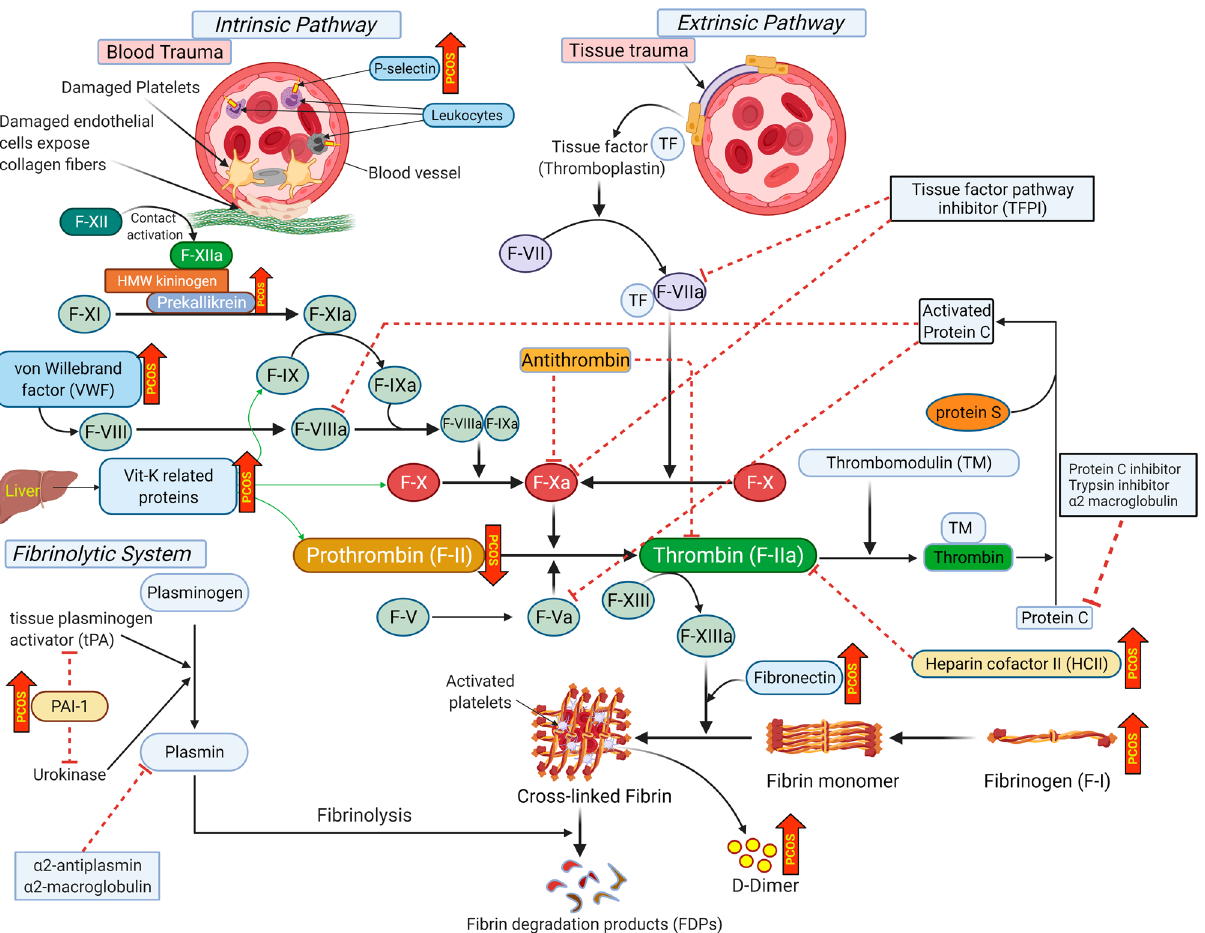
Figure 3. Schematic illustration showing altered coagulation pathway proteins in polycystic ovary syndrome (PCOS). Cellular stimulation factors and proteins involved in blood coagulation pathways [intrinsic (top left), extrinsic (top right) and fibrinolytic system (bottom left)] are illustrated. Proteins increased in women with PCOS are indicated by upward red arrows (labelled ‘PCOS’) with the protein decreased in PCOS (prothrombin) indicated by a downward red arrow. Red dotted lines indicate the inhibitory actions of the proteins in blood coagulation pathways.